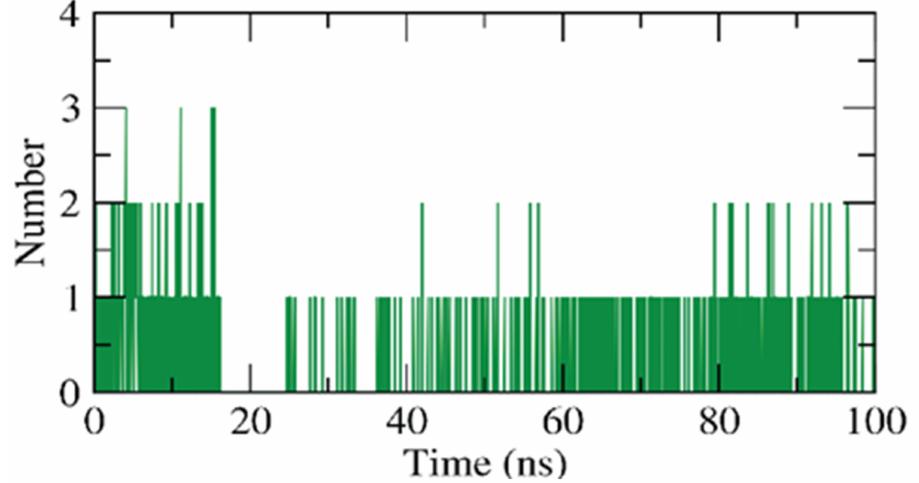
Figure 10. H-bonding of β CD-anabasine